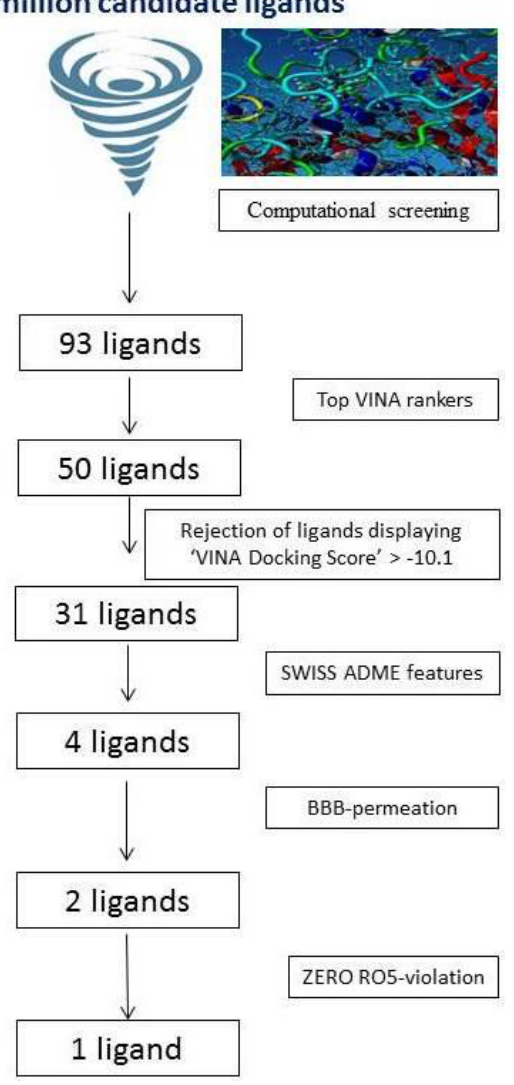
Figure 1: Molecular screening cascade for 5 mil- lion candidate ligands targeted against butyryl- cholinesterase